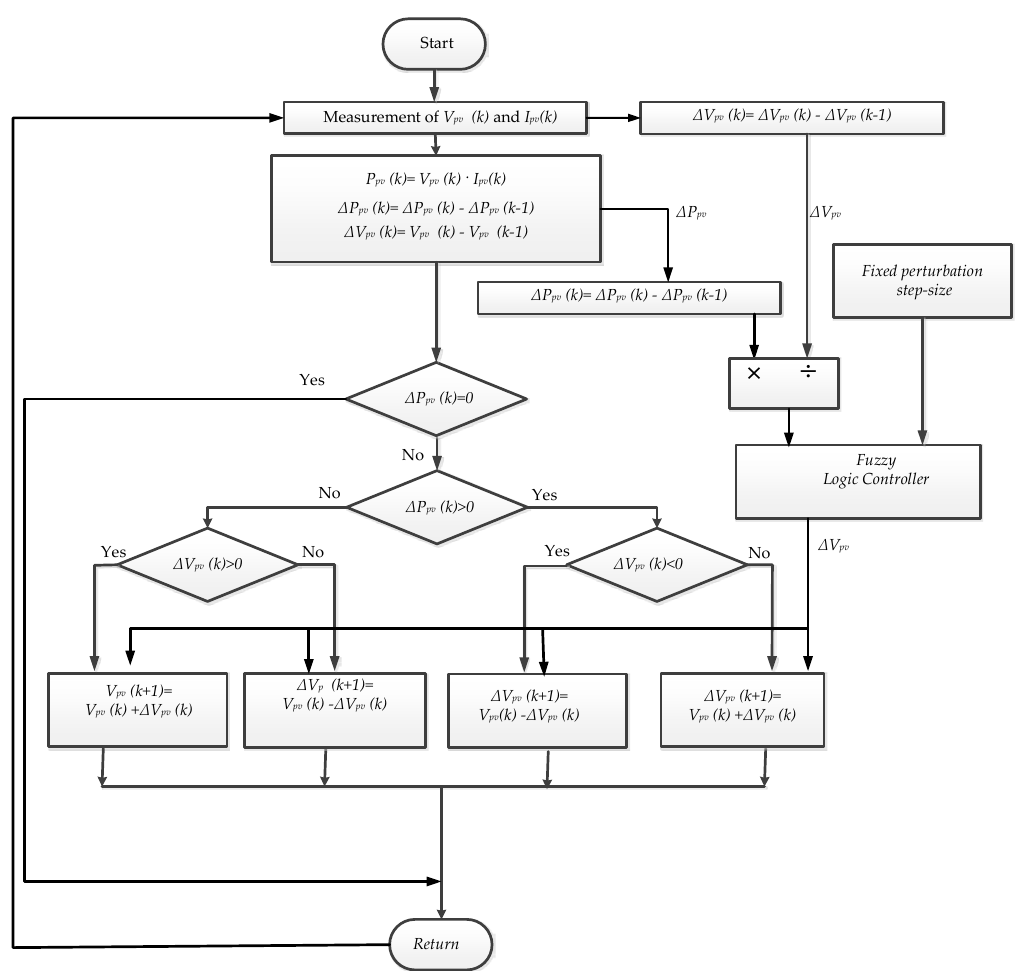
Figure 2. Fuzzy Logical Based variable step size P&O MPPT algorithm.